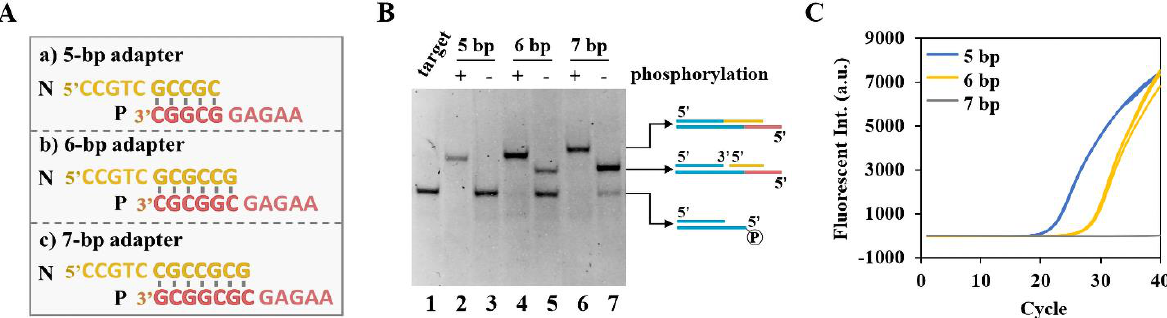
Figure 1. Ligation of DNA target by various adapters. ( A ) Sequences of the three adapters with various lengths. ( B ) DNA target (Ta/Tb) is ligated by adapters with 5–7 bp long duplex parts. Lane 1, the Ta/Tb duplex (38 bp) with a 5-nt overhang; lane 2, 4, 6, Ta/Tb is ligated by phosphorylated adapters; lane 3, 5, 7, Ta/Tb is ligated by un-phosphorylated adapters. [target DNA] = 1 µ mol/L, [adapter] = 1 µ mol/L, 2.5 U T4 DNA ligase at 25 ◦ C for 2 h. ( C ) Cyclization products are analyzed by qPCR. Ligation reactions: [558-bp target] = 300 amol (10 7 copies/ µ L), [adapter] = 10 nmol/L, 2.5 U T4 DNA Ligase at 25 ◦ C for 2 h; qPCR reactions: [primers] = 0.4 µ mol/L, 1 µ L ligation